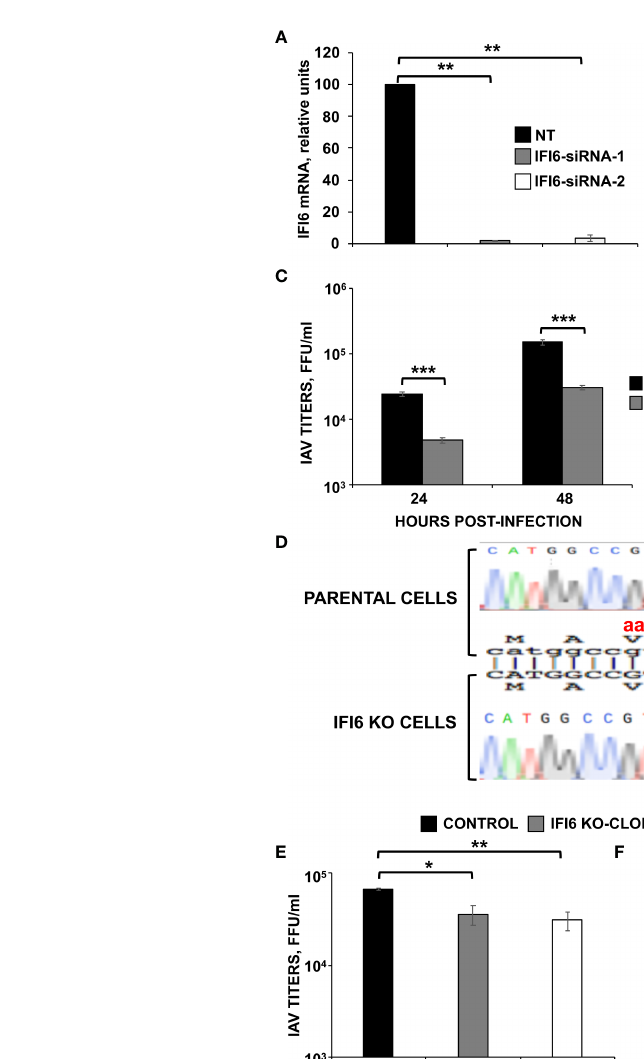
Furthermore, we compared the transcriptome of poly(I:C)- transfected HAP-1 control cells, to the transcriptome of poly(I:C)- transfected, HAP-1 IFI6 KO cells (Table 2). The genes differentially upregulated at least 2-fold, with an FDR adjusted p-value <0.05 in the IFI6 KO cells, were classi fi ed according to their biological process, showing that genes involved in: negative regulation of viral process, negative regulation of viral genome replication, defense response to